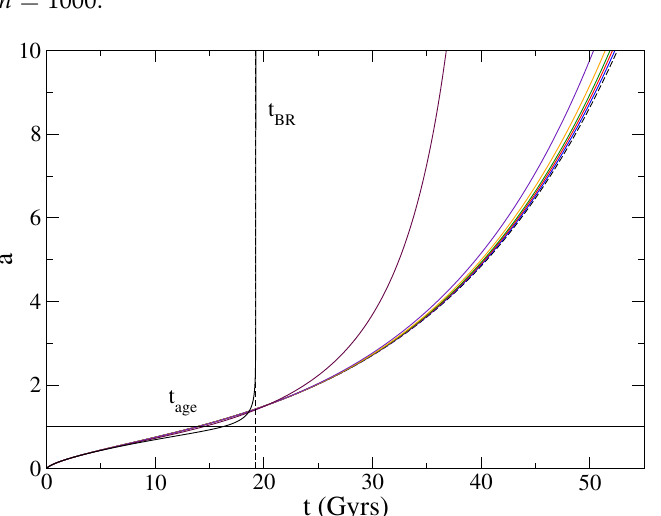
Figure 2. Scale factor a as a function of the cosmic time t for Ω m ,0 = 0.309, B = 3.53 × 10 − 3 and n = 0,1,2,3,5,10,100,1000. This figure shows the big rip time t BR (for n = 1000 > 2) at which the scale factor becomes